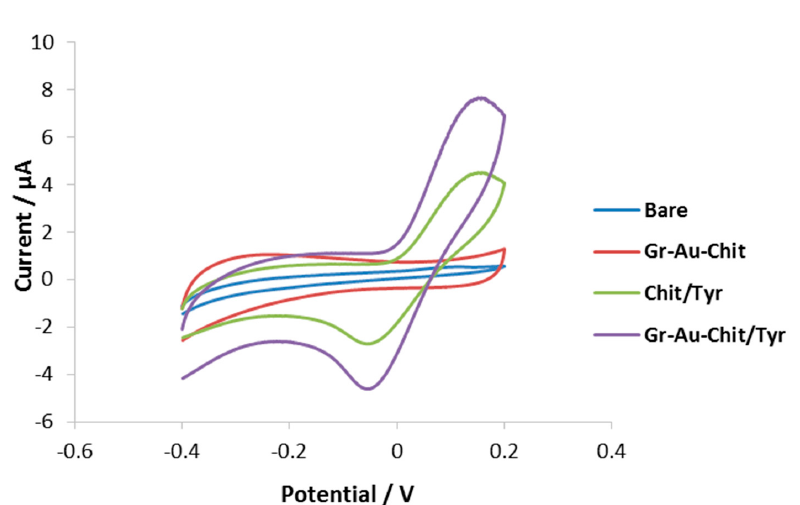
Figure 4. Cyclic voltammograms of phenol (0.5 × 10 − 5 M) at (a) bare SPCE, (b) SPCE/Gr-Au-Chit, (c) SPCE/Chit-Tyr and (d) SPCE/Gr-Au-Chit/Tyr. Scan rate of 100 mV/s and supporting electrolyte of 0.1 M PBS (pH 7.0) were used. PBS = Phosphate buffer solution.